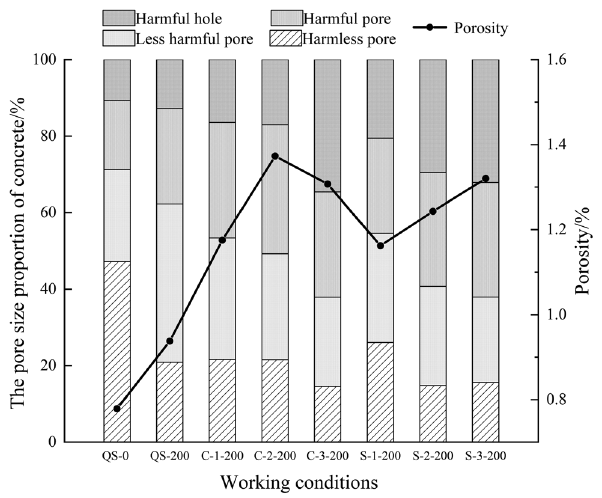
Figure 8: Pore size proportion of concrete after freezing and thawing